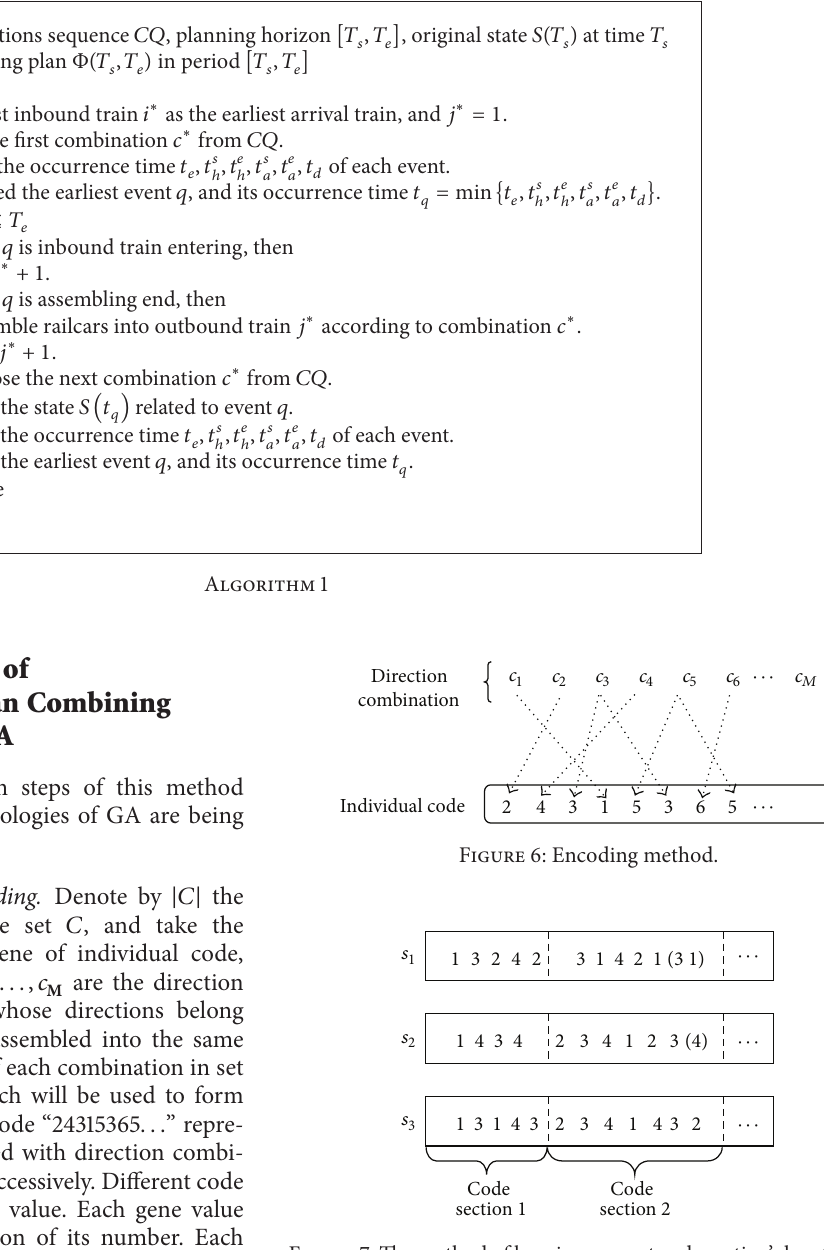
Figure 7: The method of keeping current code section’s length to be the